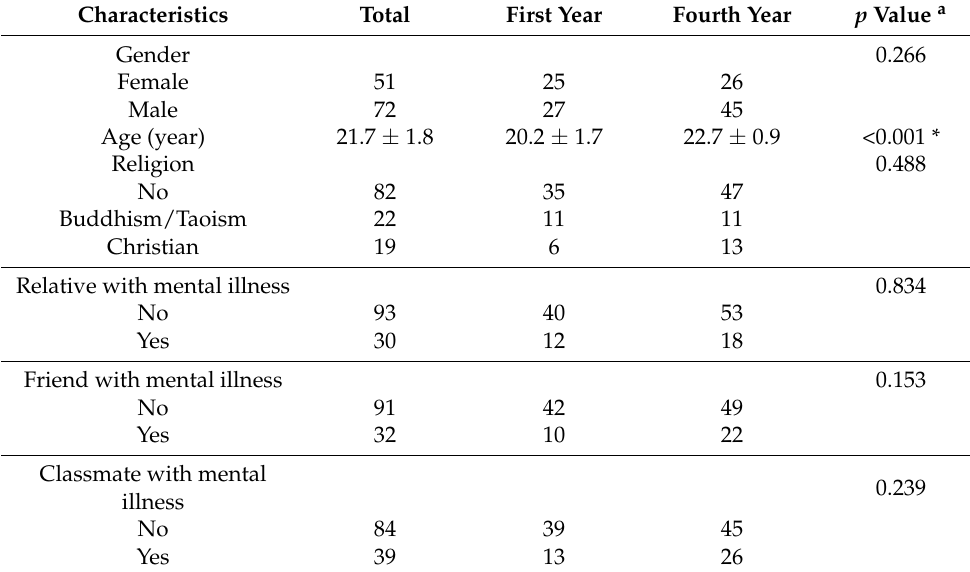
Table 1. Demographic characteristics of participants.